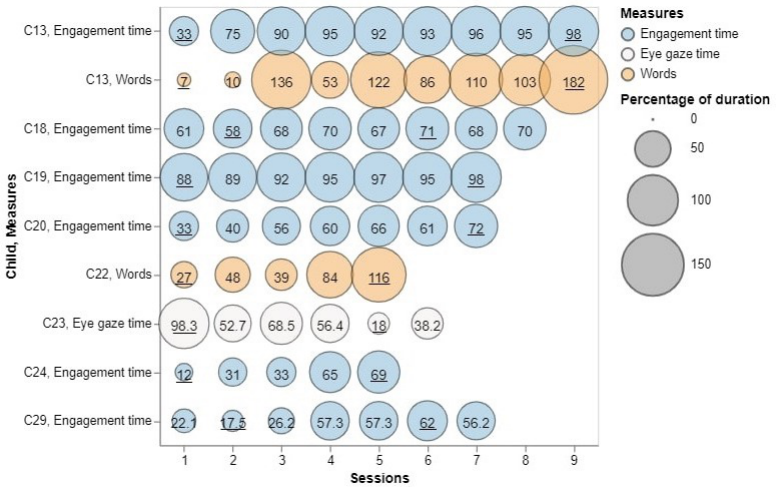
Figure 3. The significant differences of individual analyses over sessions. n for p <